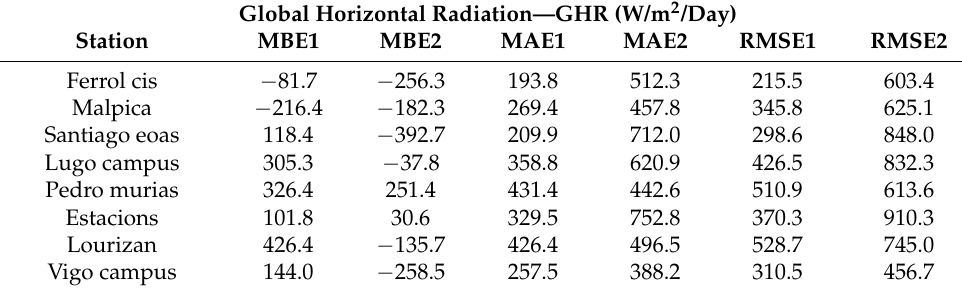
Table A3. GHR error statistics for the 8 stations.